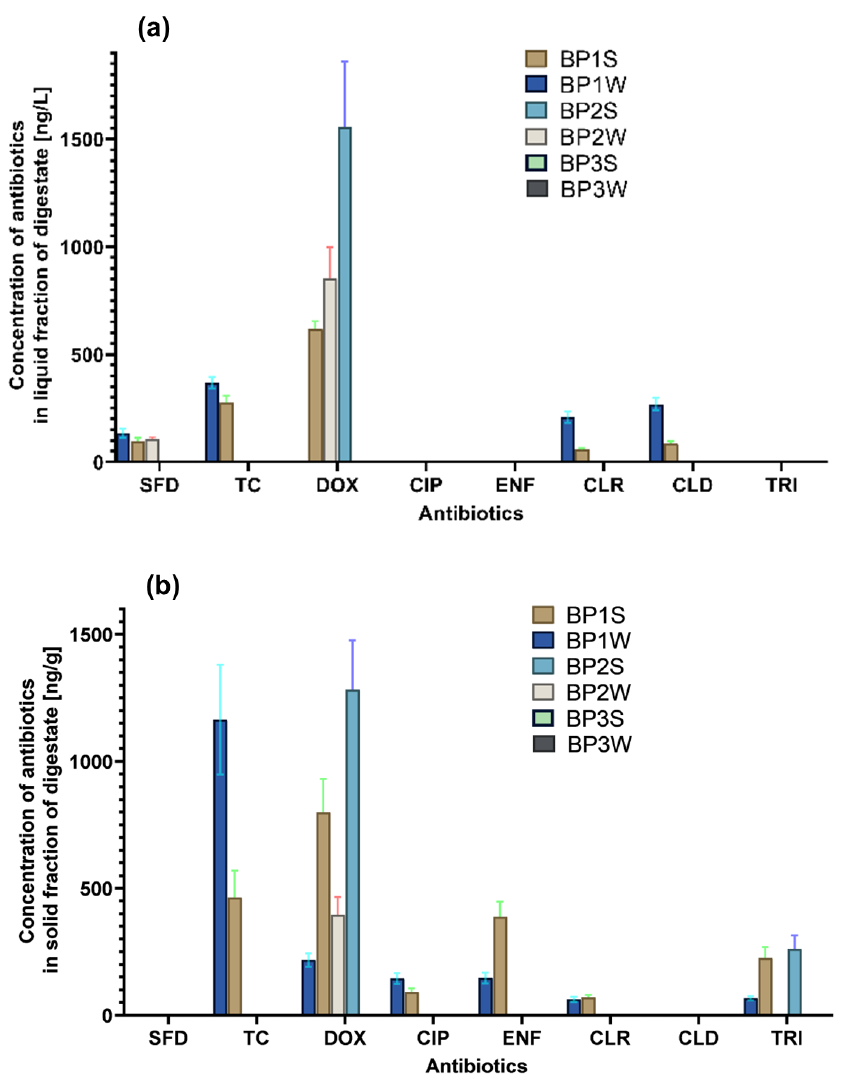
Figure 1. Concentrations of antibiotics in ( a ) liquid and ( b ) solid fractions of digestate. Error bars denote standard deviation (SD).